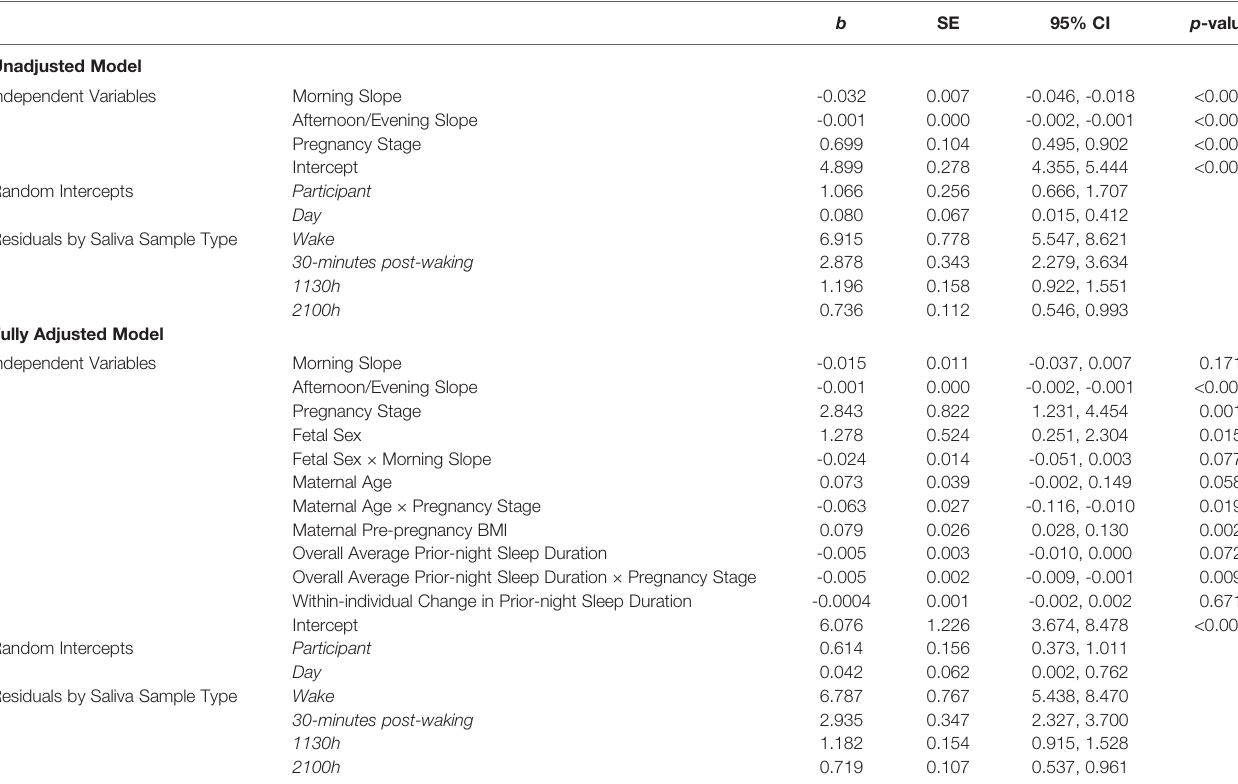
b SE 95% CI p -value